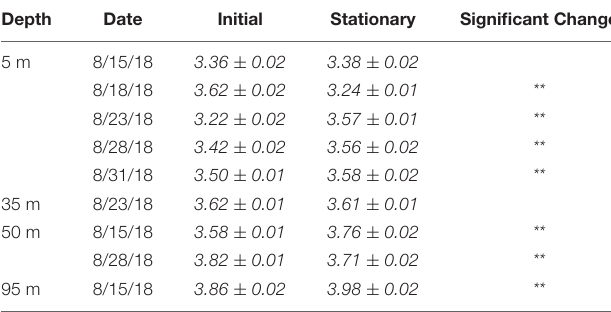
TABLE 3 | Shannon–Wiener H Index, ± 95% confidence